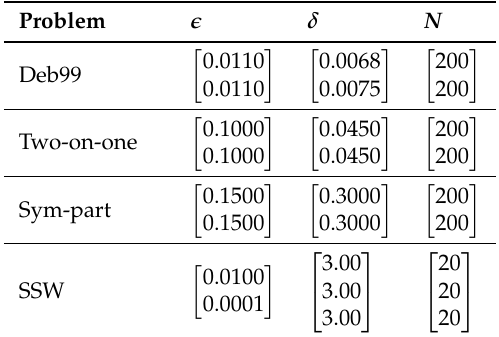
Table 2. Parameters used for each problem.